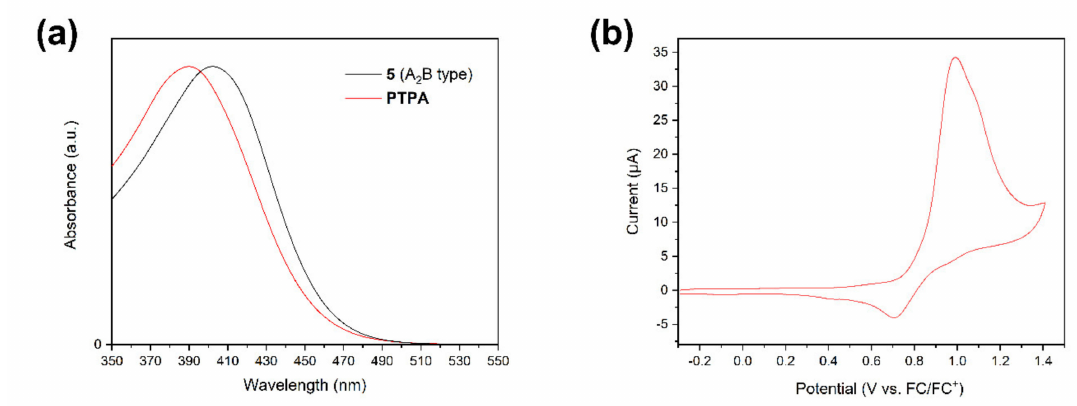
Figure 5. ( a ) Normalized UV/Vis spectra of 5 (black) and PTPA (red) in acetone. ( b ) Cyclic voltammogram of 0.1 mM PTPA in acetonitrile, containing 100 mM TBAHFP at a scan rate of 50